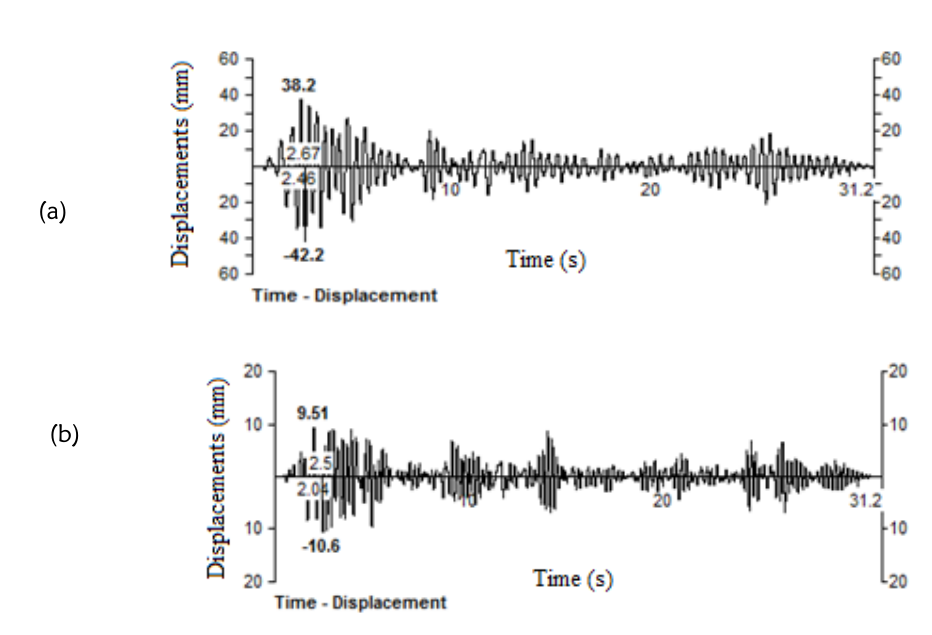
Figure 11: Time-dependent peak-to-peak displacements along x - direction for ( a ) unreinforced (80.4 mm) and ( b ) reinforced (20.11 mm) structure